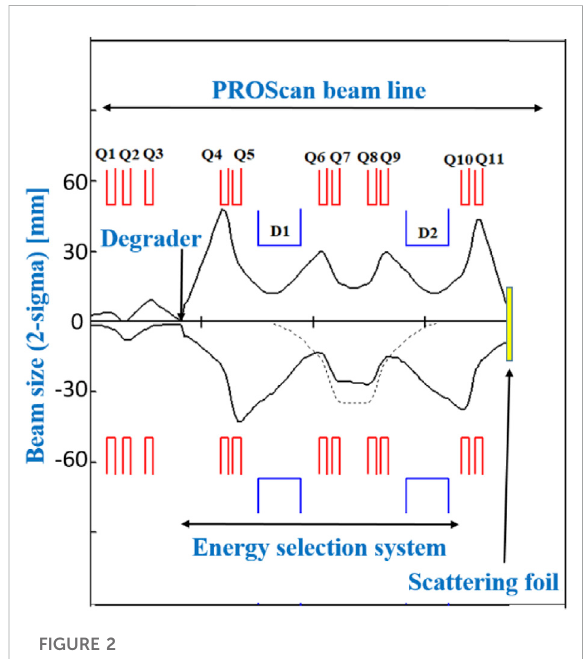
FIGURE 2 New beam optics to achieve beam waist and particular beam phase-space at the entrance of the scattering foil The beam envelopes show the beam size in 2-sigma values and the dispersion (dashed line) along PSI ’ s ESS beam line (The lower halfof fi gureshowsbeamenvelopeinX-plane(bendingplane)and the upper half shows envelope in Y-plane). The red line below the quadrupole name and the blue line below the dipole name, represent the element aperture (V above and H below the beam